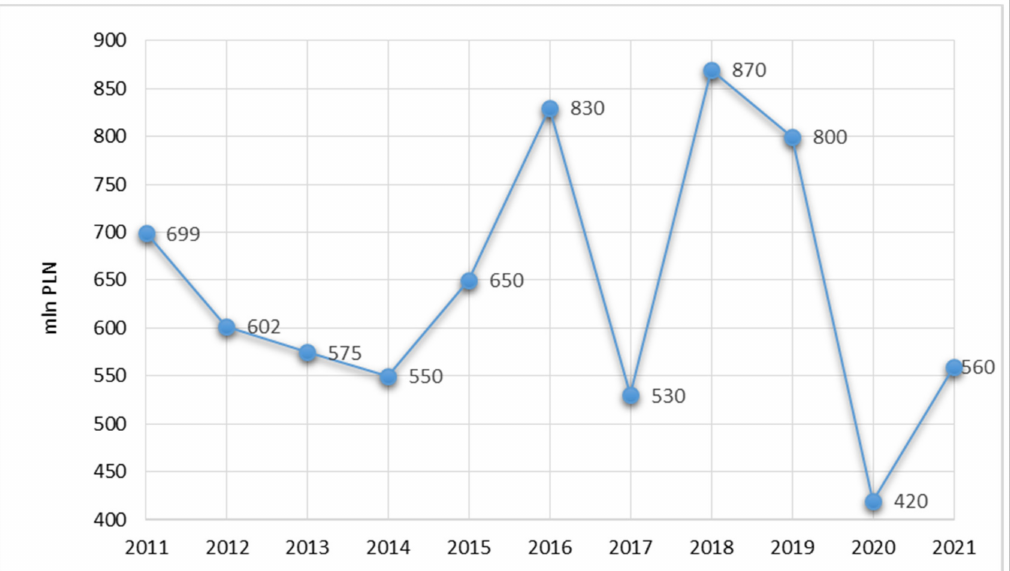
Figure 4. Expenditure on investment in the Polish steel industry in the last decade. Source: Polish Steel Association, Katowice, Poland [67].